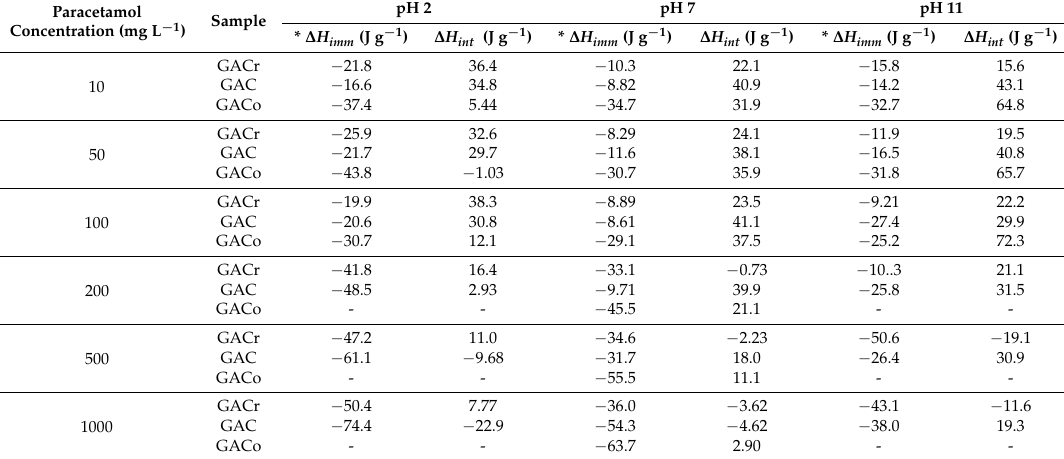
Table 4. Immersion and interaction enthalpies of paracetamol on activated carbons at different solution